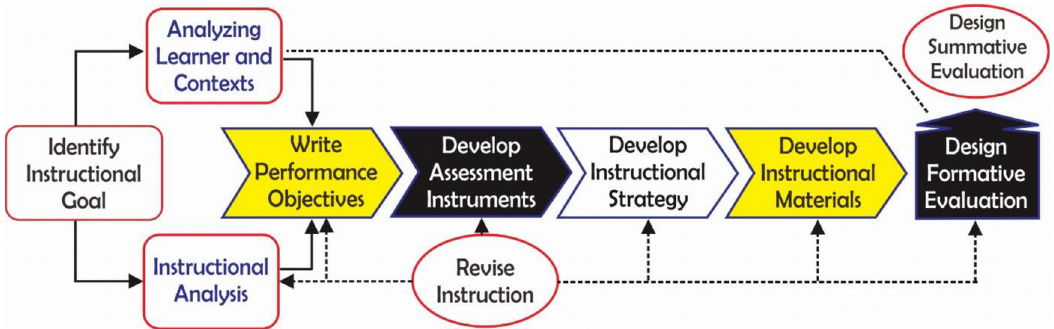
Figure 1. Model of instructional design by Dick & Carey (Dick,